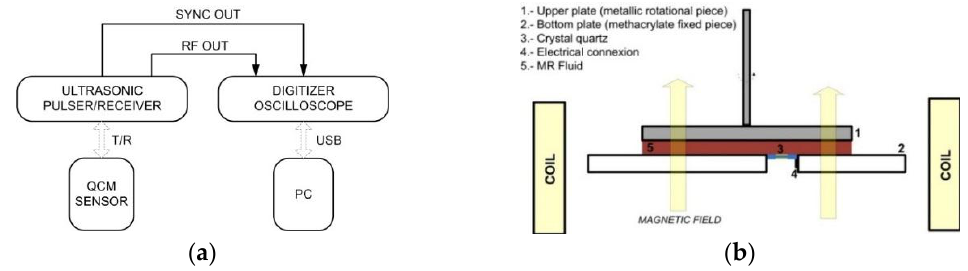
Figure 2. ( a ) Scheme of the experimental set up; and ( b ) measurement cell adapted to the rheometer (not to scale). (not to scale).